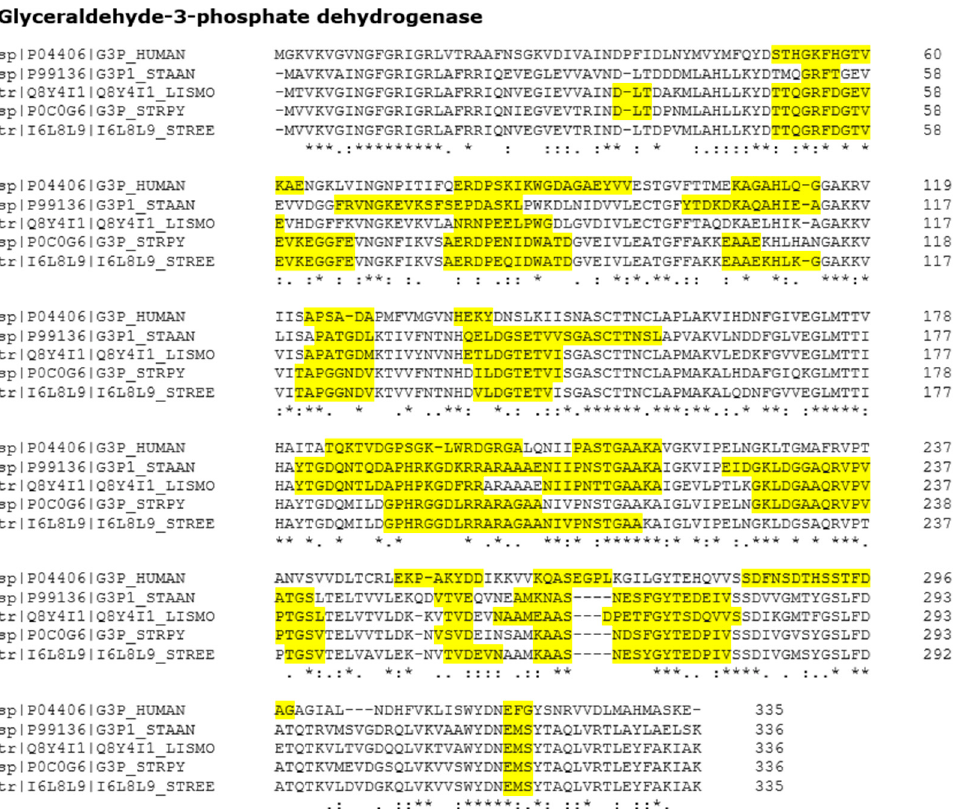
Figure 1. Sequence multi-alignment between human GAPDH and different pathogenic microorganisms with the predicted epitopes highlighted in yellow showing a clear conservation in the immunogenic areas of the proteins. STAAN = Staphylococcus aureus , LISMO = Listeria monocytogenes, STRPY = Streptococcus pyogenes , STREE = Streptococcus pneumoniae . Linear B-cell epitopes were predicted with BepiPred. An * (asterisk) indicates positions which have a single, fully conserved residue. A: (colon) indicates conservation between groups of strongly similar properties as below—roughly equivalent to scoring > 0.5 in the Gonnet PAM 250 matrix. A. (period) indicates conservation between groups of weakly similar properties as below—roughly equivalent to scoring =< 0.5 and > 0 in the Gonnet PAM 250 matrix.